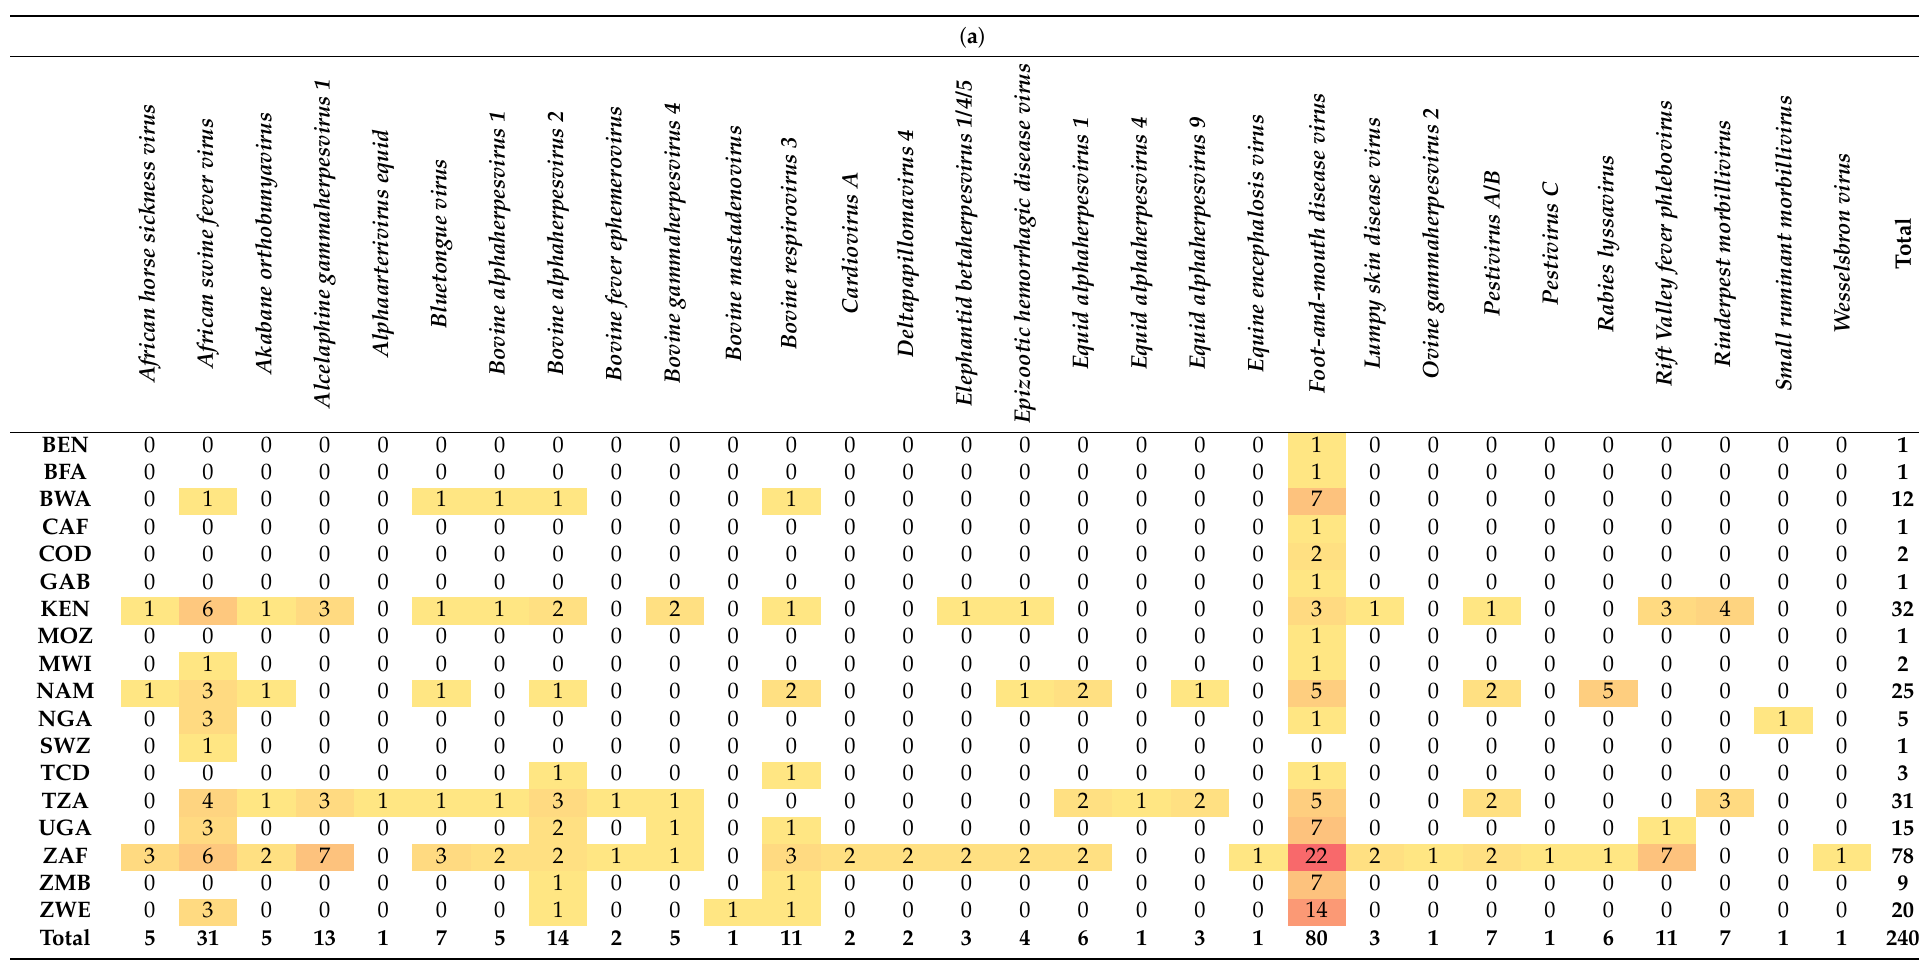
Table 5. ( a ) Viruses diagnosed in ungulates per African country. ( b ) Country codes indicated are as described in the ISO 3166 international standard. ( a